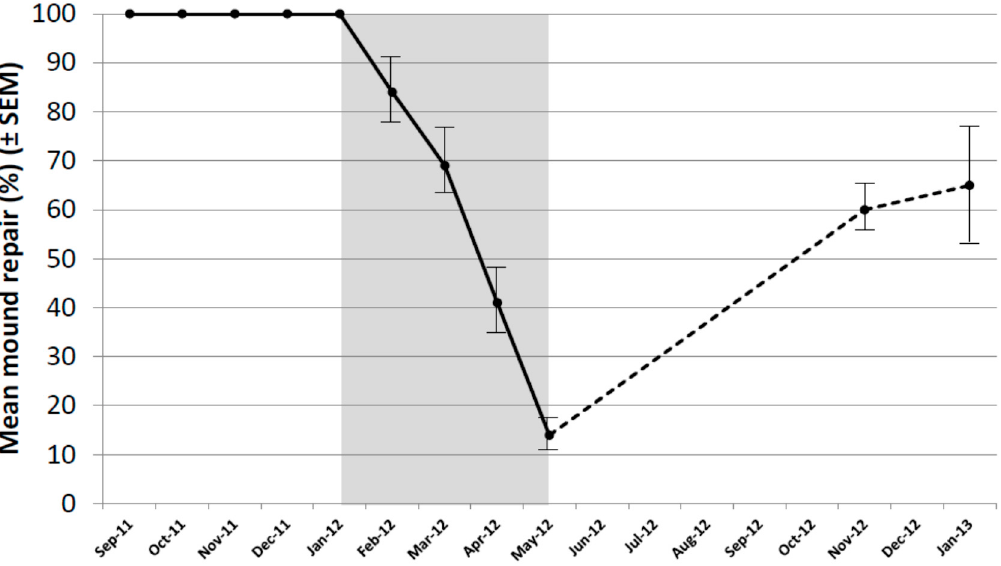
Figure 3. Mound repair (%) following experimental damage using a hand-held auger in untreated mounds only, covering the extended period of September 2011 to January 2013. Period of the baiting study shown in grey. Bars indicate SEM.